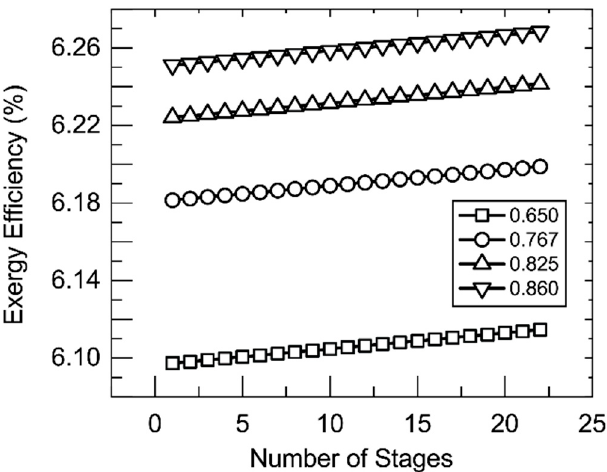
Figure 10. Exergy efficiency as the number of stages increases. Shell-side feed. Inner radius 350 um, thickness 300 um, R / a 0.35, feed velocity 5 m/s, vacuum pressure 5 kPa, tortuosity 2, pore diameter 400 nm, porosity 0.5, and a value for the ṁ 11 = 200 kg/hr. Legend indicates recovery ratio. Recovery ratio 0.65 corresponds to mass fraction of 0.1 for the salt in stream 7.